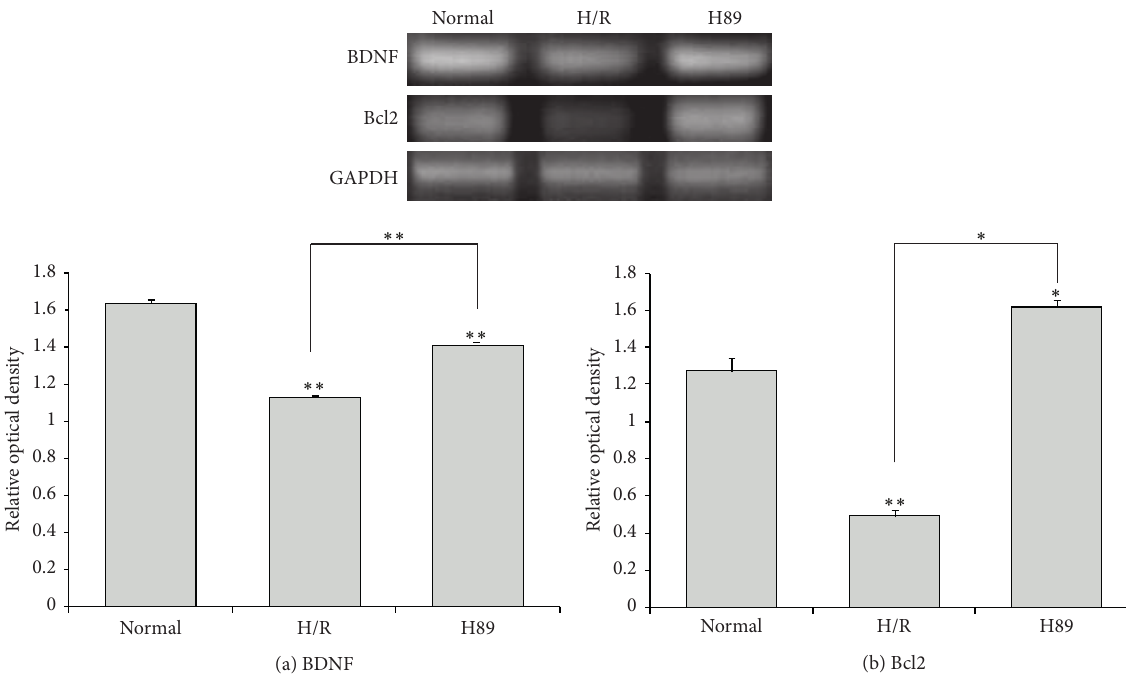
Figure 7: The measurement of BDNF and Bcl2 mRNA level in Neuro2A cells after H/R-induced injury. (a) BDNF and (b) Bcl2 mRNA levels were measured by using RT-PCR. The H89 pretreatment group showed higher mRNA levels of (a) BDNF and (b) Bcl2 compared to the hypoxia reperfusion injury group. Data were expressed as mean ± S.E.M, and each experiment included 3 repeats per condition. GAPDH was used as a control. Differences were considered significant at ∗ 𝑃 < 0.05 and ∗∗ 𝑃 < 0.001 . Normal: the normal control group, H/R: 4hr hypoxia and 18hr reperfusion injury group, H89: 2 hr PKA inhibitor H89 treatment group before 4hr hypoxia and 18hr reperfusion injury.